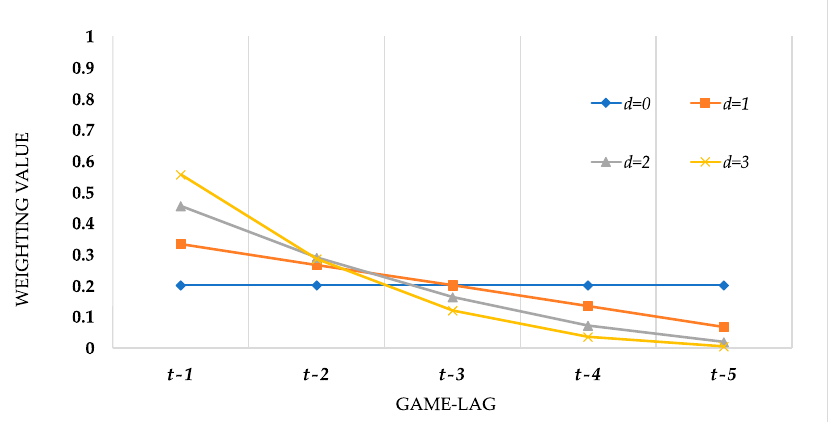
Figure 4. Weighting distribution of each data point with different weighting control parameter ( d ) from 0 to 3 under game-lag = 5.